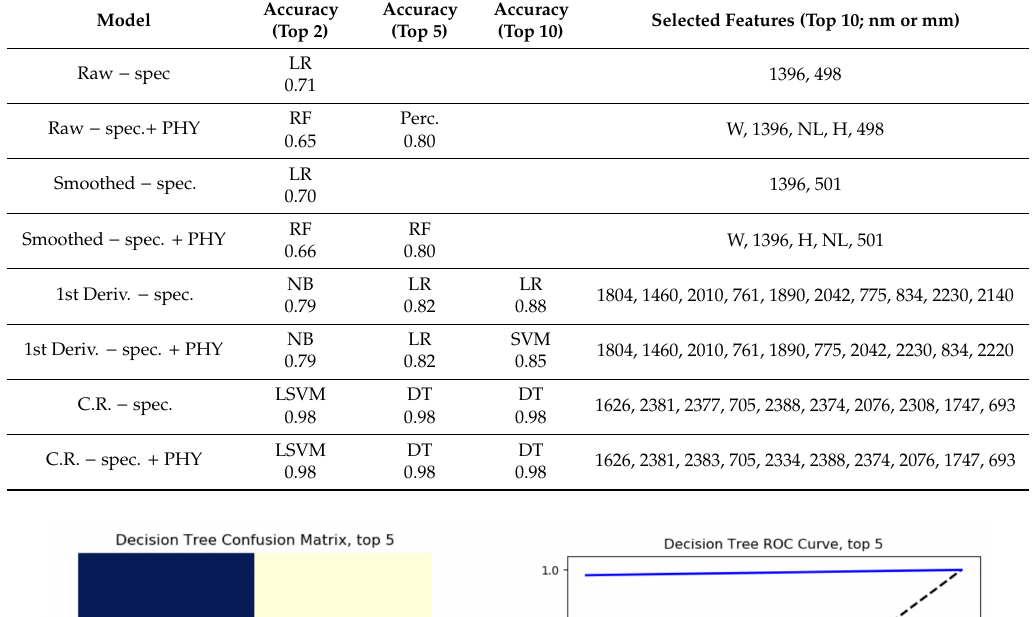
Table 5. Results for growth stage classification—flowering. Note the high accuracy in CR models achieved without the use of biophysical attributes. Accuracy Accuracy Accuracy Model (Top 2) (Top 5) (Top 10)